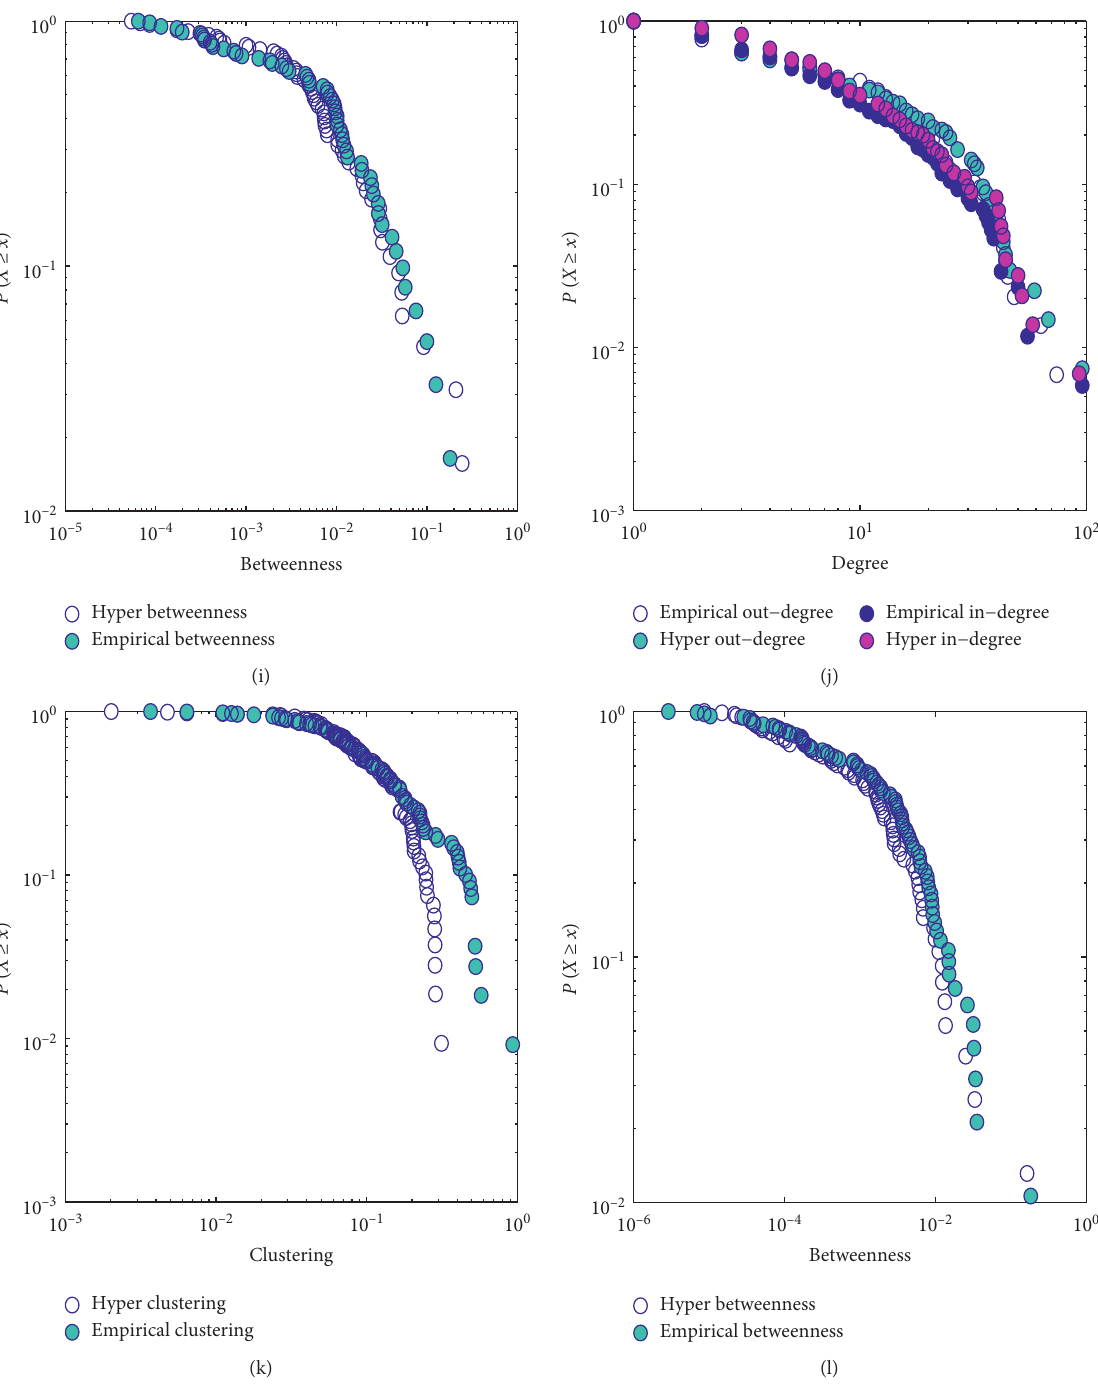
Figure 2: Comparison results of the cumulative distribution: degree, clustering coefficient, and betweenness centrality. (a–l) The topological properties in hyperbolic space and empirical directed networks to evaluate the validity of the model. The results of (a–c) the C elegans neural network, (d–f) email network, (g–i) international migration network, and (j–l) international trade network, respectively, are